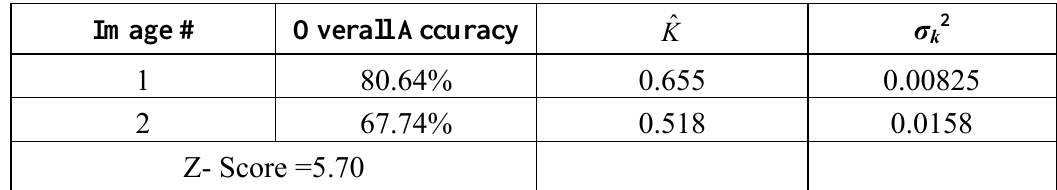
Table 4C. Accuracy assessments for the classification results in Tables 4A and